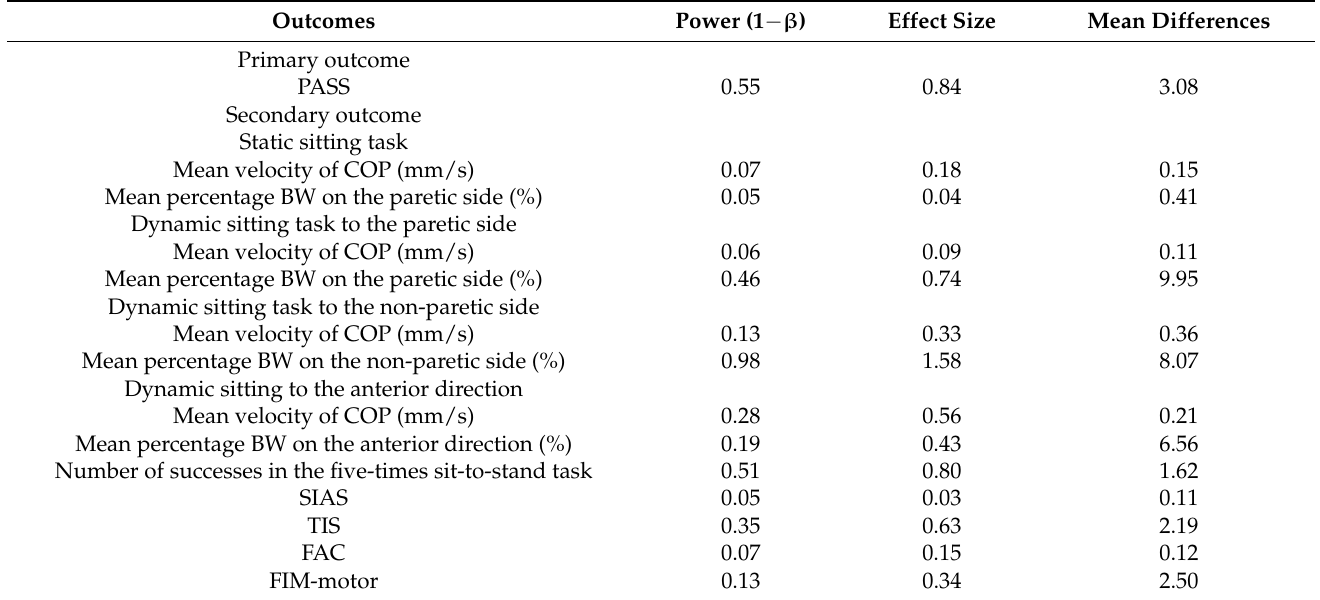
Table 3. Post hoc power calculations for outcomes in the ITT